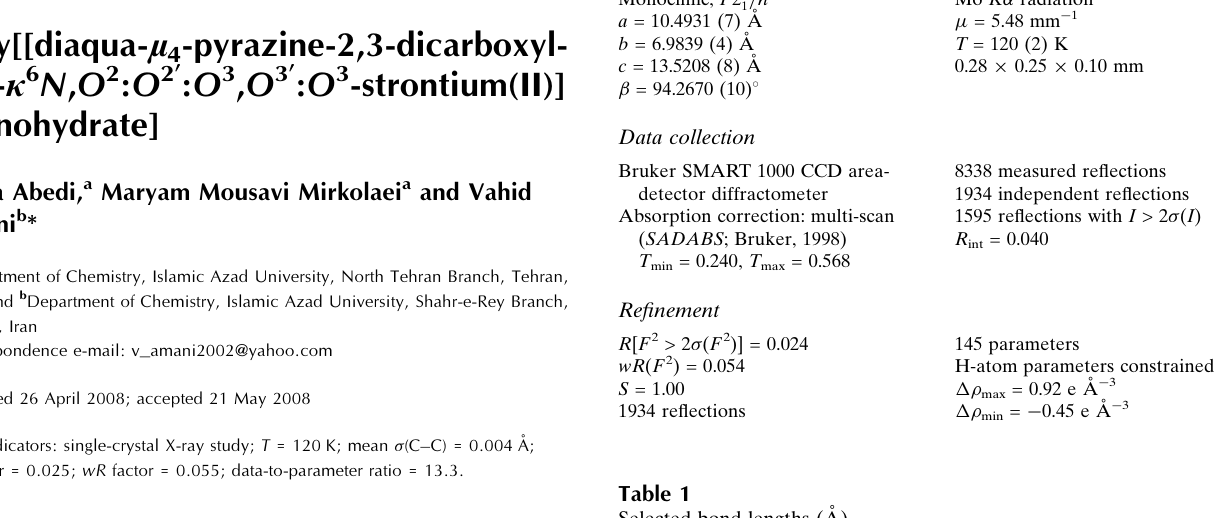
Selected bond lengths (A˚ ).